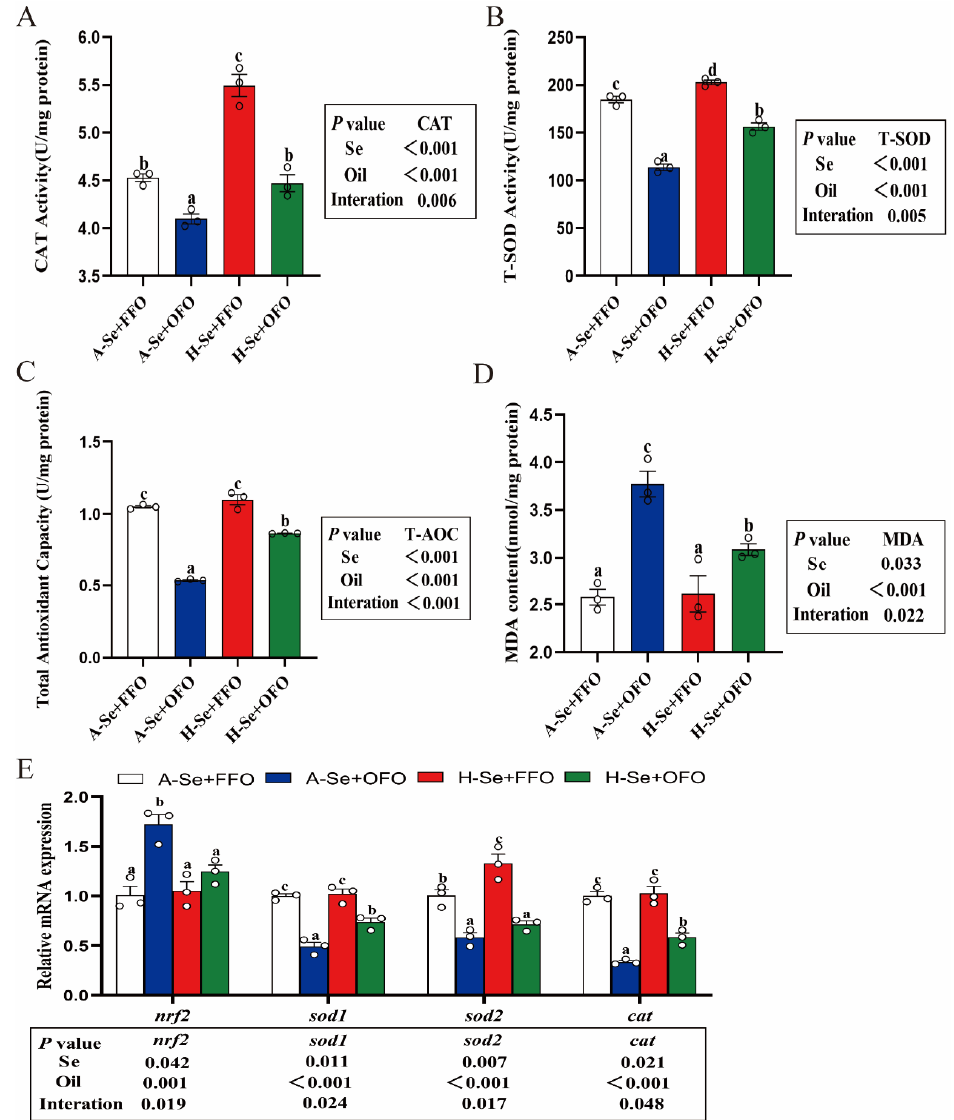
Figure 3. High levels of selenium attenuate the oxidative stress that was induced by oxidized fish oils in the intestine of yellow catfish. ( A ) CAT activity. ( B ) T ‐ SOD activity. ( C ) T ‐ AOC. ( D ) MDA content. ( E ) The genes mRNA expression related to oxidative stress. All data were mean ± SEM ( n = 3). “a–d” indicate meaningfulness at p < 0.05. p value was calculated by two ‐ way ANOVA. CAT, catalase; T ‐ SOD, total superoxide dismutase; MDA, malondialdehyde.